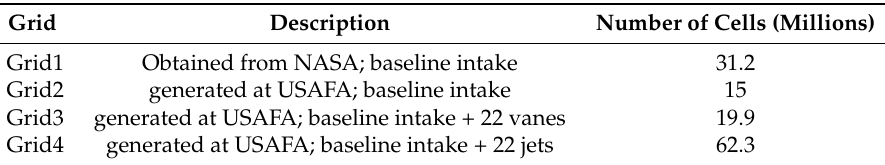
Table 2. Detail of computational grids.